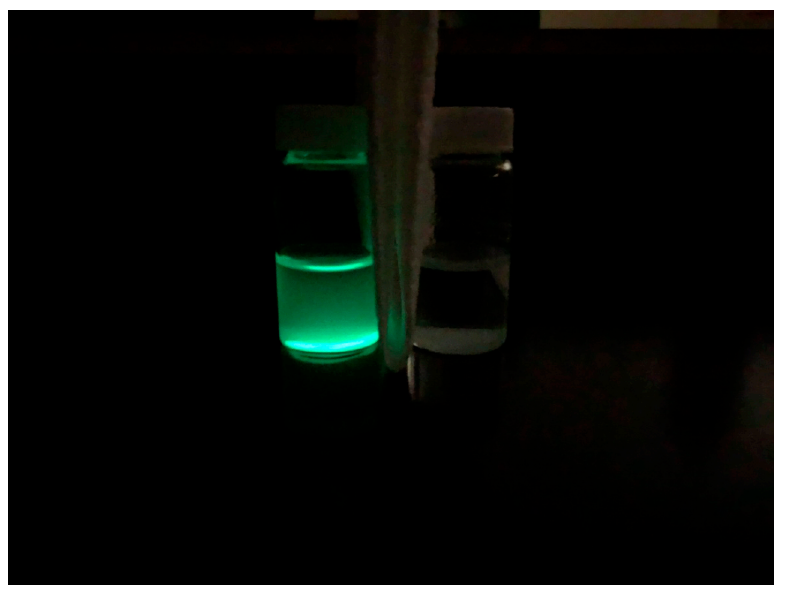
Figure 3. Luminescence of the SRA phosphor before ( left ) and after ( right ) acetic acid leaching for 48